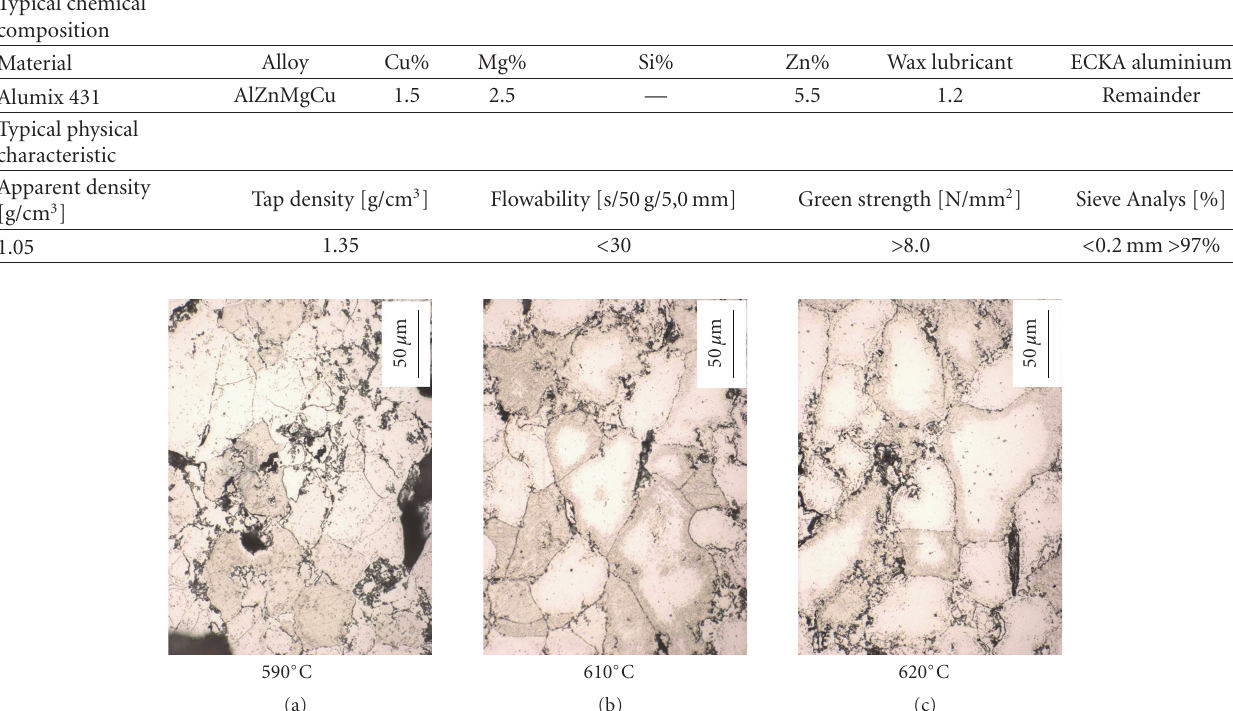
Table 1: Typical chemical composition and physical characteristic of Alumix 431.